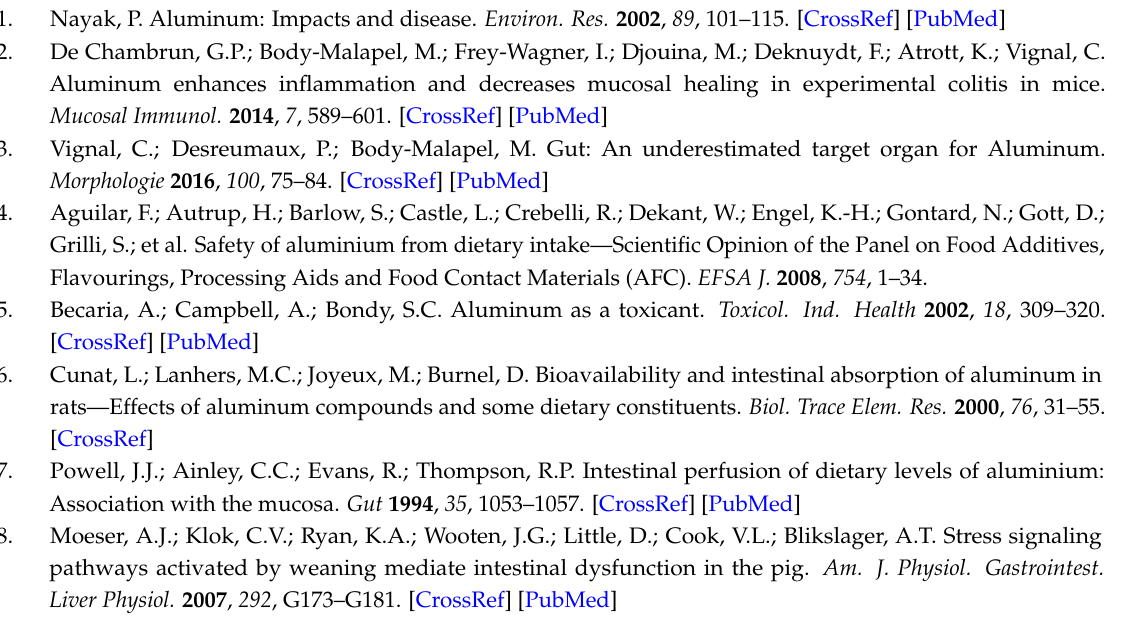
s1, Figure S1: Effects of gradient concentration of Al on the viability of HT-29 cells. Values are presented as the mean ± SEM. Figure S2: Effects of L. plantarum CCFM639 on Al-induced cytotoxicity in HT-29 cells. (A) Representative histogram of flow cytometric analysis in HT-29 cells. Normal cells (lower left quadrant); early apoptotic cells (lower right quadrant); late apoptotic cells (upper right quadrant); necrotic cells (upper left quadrant). (B) Cell viability in intervention and therapy assays. (C) Percentage of apoptotic cells (the cells in early and late apoptosis) in intervention and therapy assays. Values are presented as the mean ± SEM. The different letters a, b and c indicate statistically significant changes among four groups ( p < 0.05). Figure S3: Effects of L. plantarum CCFM639 on intracellular ROS levels. The ROS was stained with 2,7-dichlorofluorescein diacetate (DCFH-DA; green) and observed with confocal